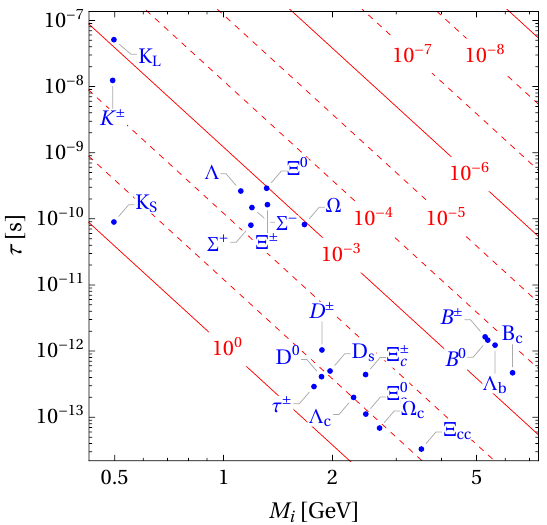
Figure 5. Heavy neutrino coupling (red lines) compared to potentially relevant SM backgrounds (blue dots) as function of mass and life time, cf. also (cid:12)gure